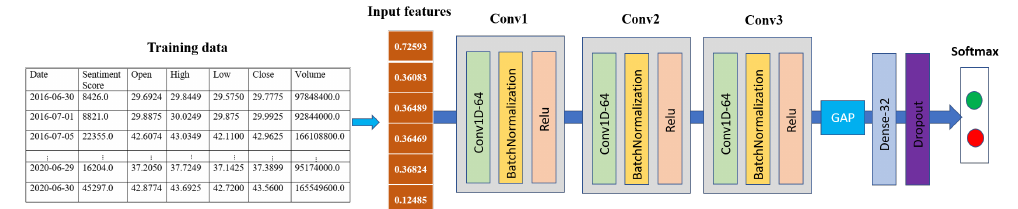
Figure 3. 1D Convolutional neural network architecture for sentiment